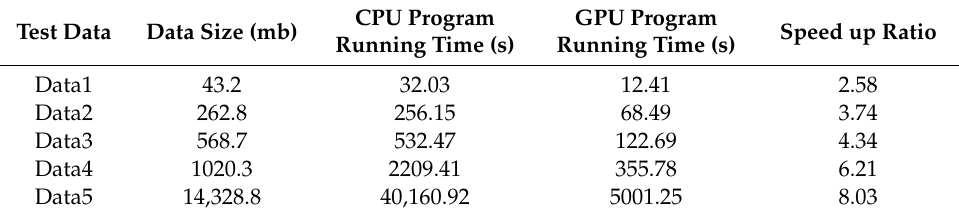
Table 1. The comparison of processing speed between CPU and